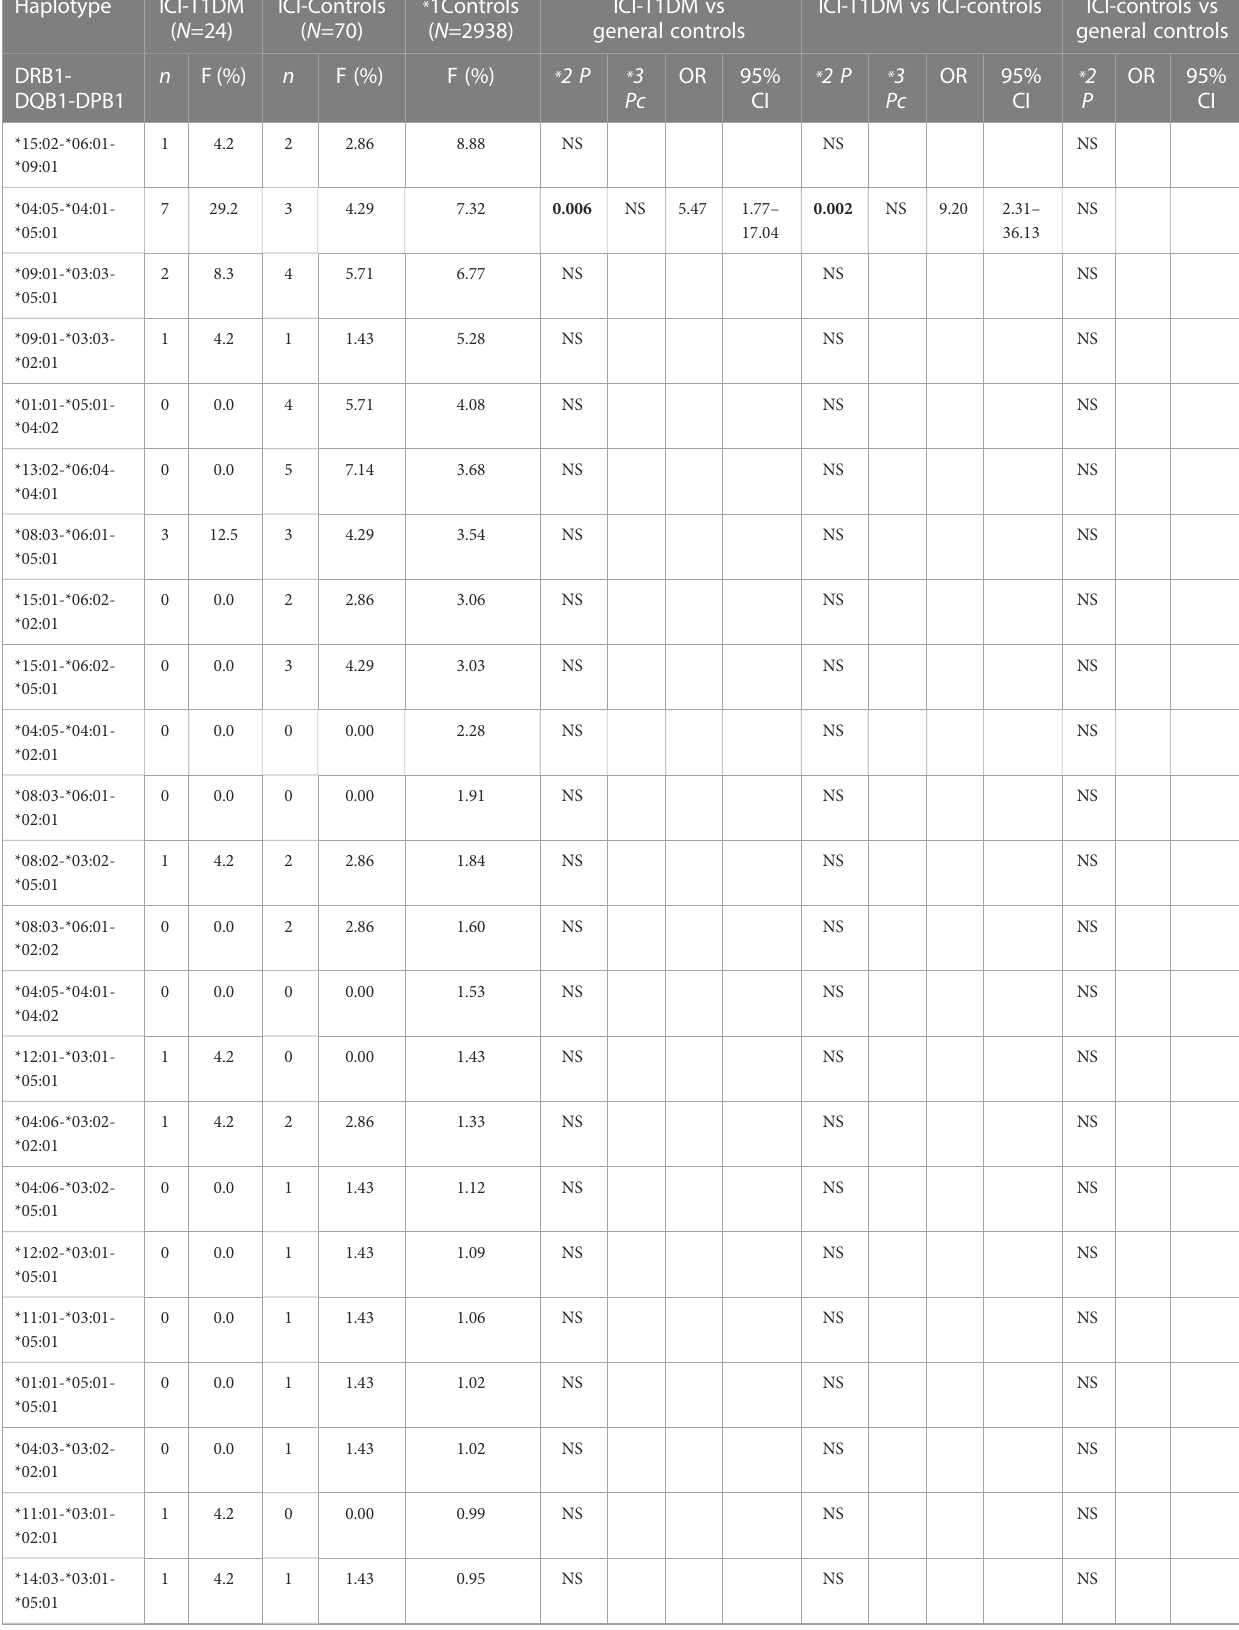
TABLE 2E Haplotype frequencies of HLA-DRB1-DQB1-DPB1 in patients with ICI-T1DM.